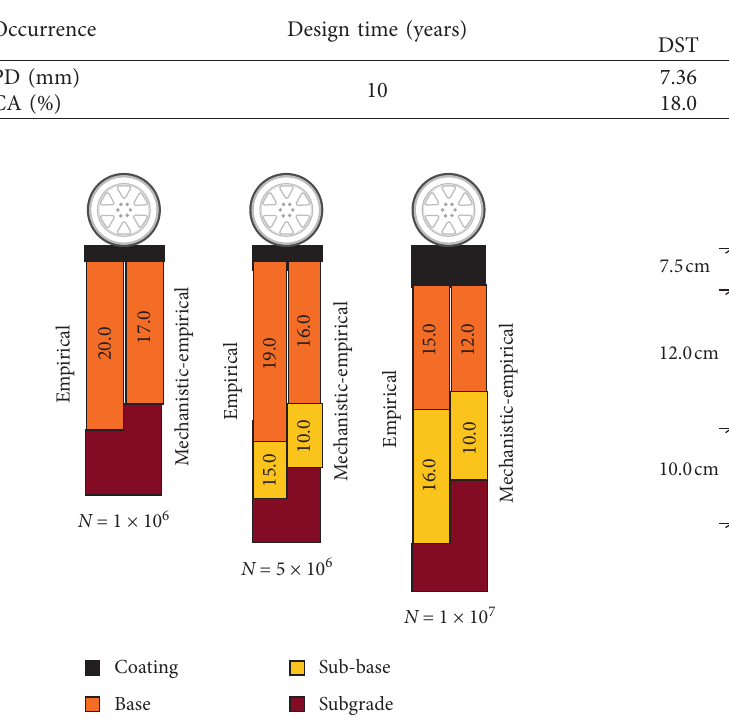
Table 7: Total values of PD and WTS obtained in the design.